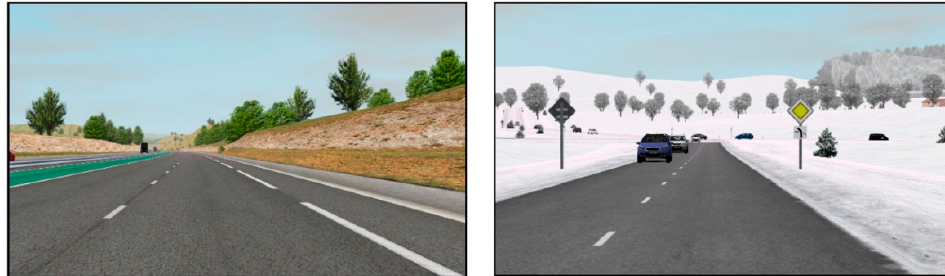
Figure 2. Screenshots of the driving scenarios employed in this study. Left: highway with low traffic; right: country road with many vehicles and icy roads. Image is distributed under the Creative Commons Attribution License and taken from the study by Gruden et al. [4].